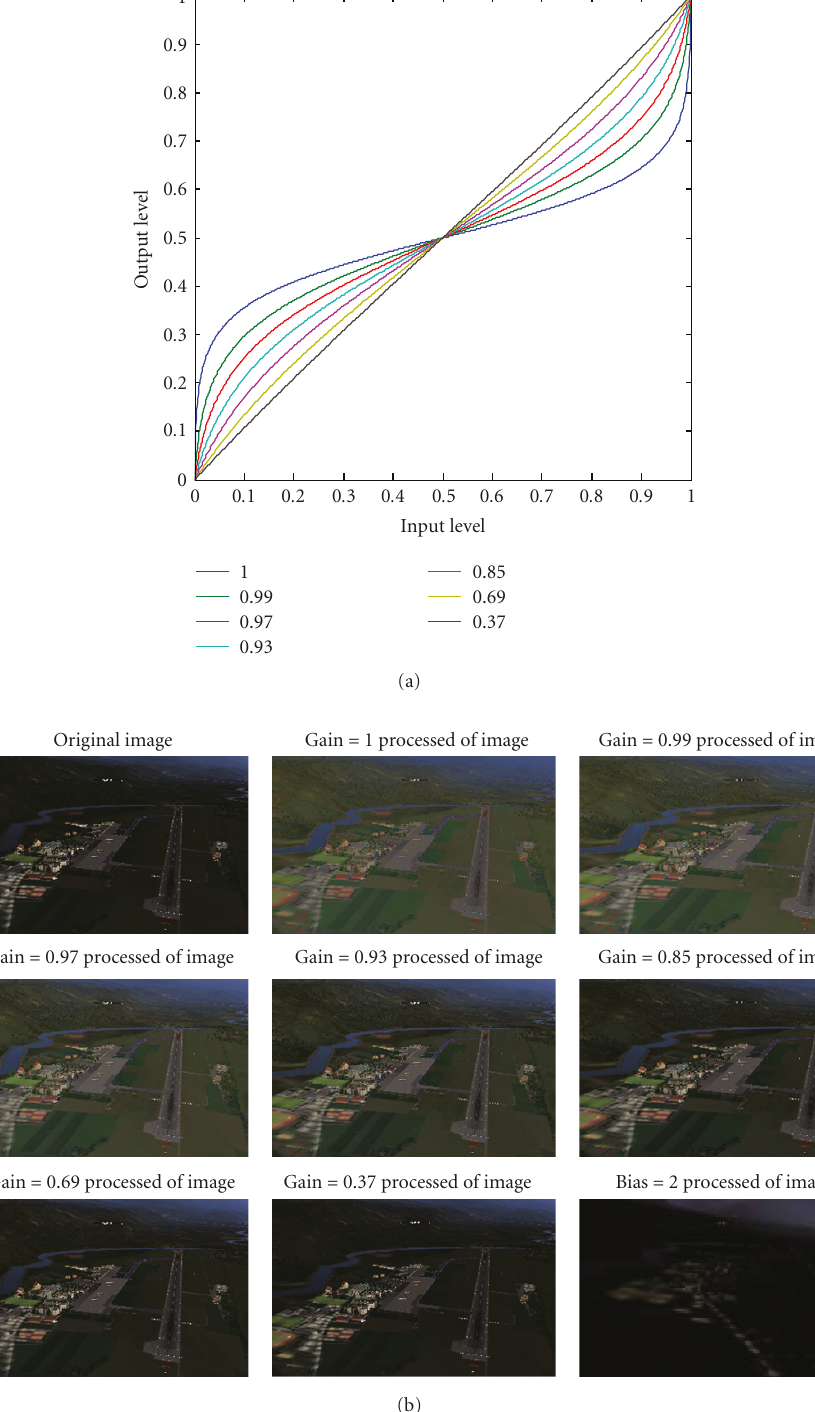
Figure 14: The gain function determines the steepness of the curve. Steeper slopes map a smaller range of input values to the display range. (a) Bias parameter fixed (bias = 1) and eight di ff erent gain values of mapping curves. (b) Fixed bias = 1, processed of